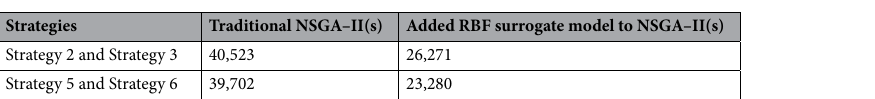
Figure 9. Comparison of traditional methods for optimizing traversal fertilization dates and using RBF optimization of traversal fertilization dates.